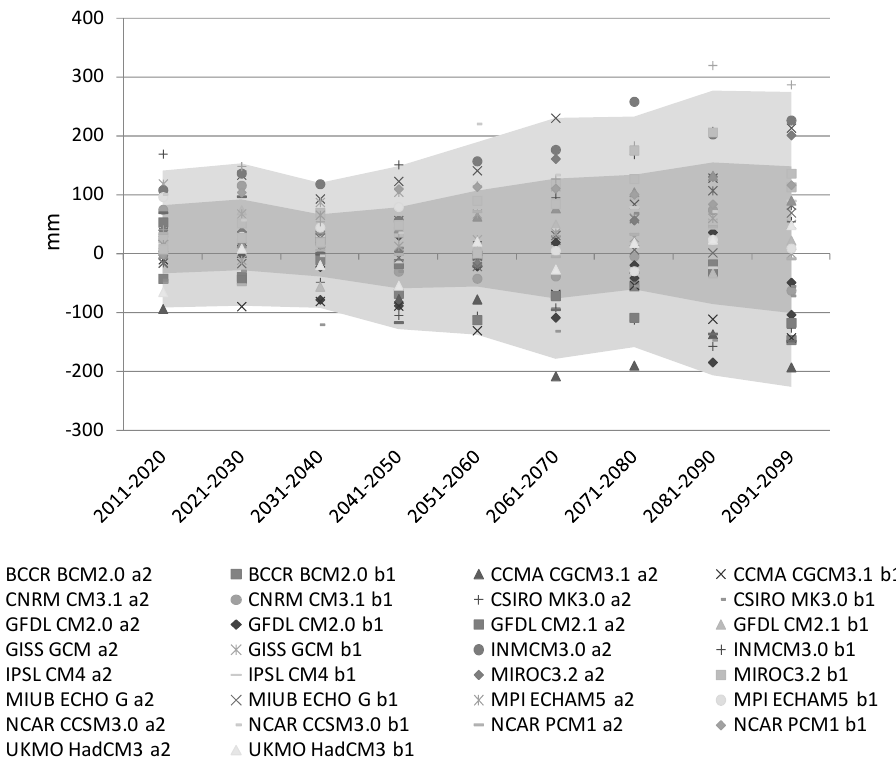
Figure 2. Change in average annual precipitation (mm) for decades of the 21st century, averaged over the BNH, relative to the 1961–1990 mean. Model data from the CMIP3 archive [12], processed using climate wizard [19]. Shading indicates one and two standard deviations from the multi-model ensemble